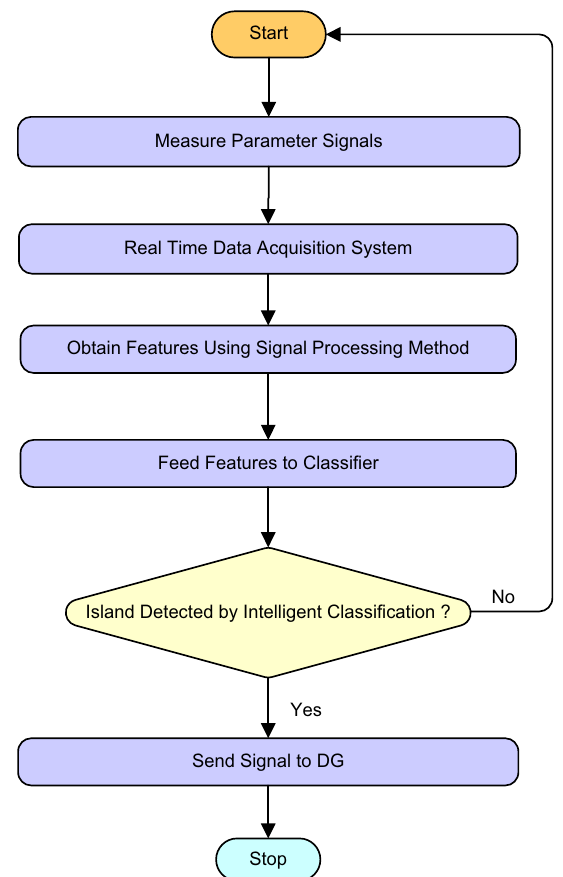
Fig. 8 Algorithm for intelligence-based method islanding detection method